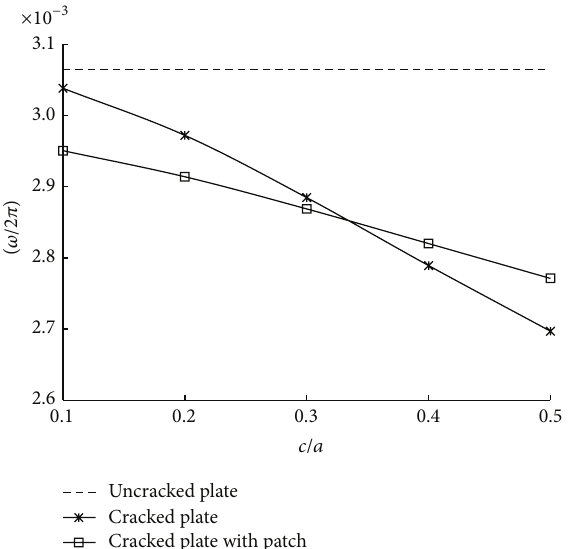
Figure 8: Variation of natural frequencies with patch